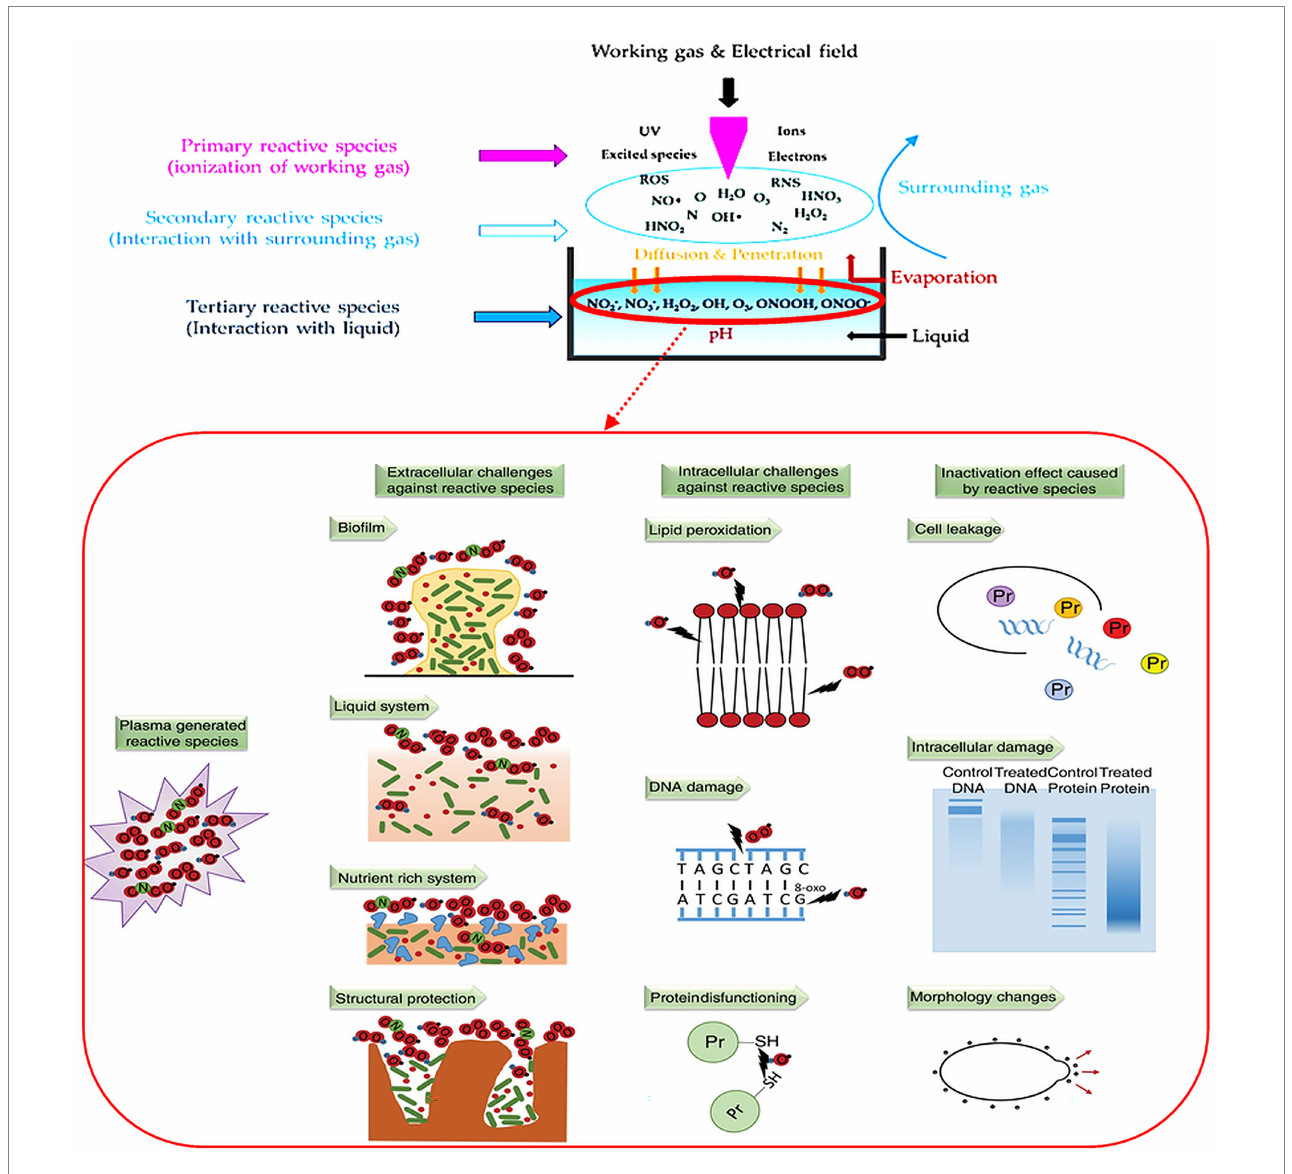
FIGURE 2 Mechanisms of plasma inactivation of ARBs and ARGs in liquid showing the reactive species released into pollutant containing aquatic matrix and their subsequent interaction with microbial communities and morphological and genetic components (Bourke et al., 2017; Courti et al.,